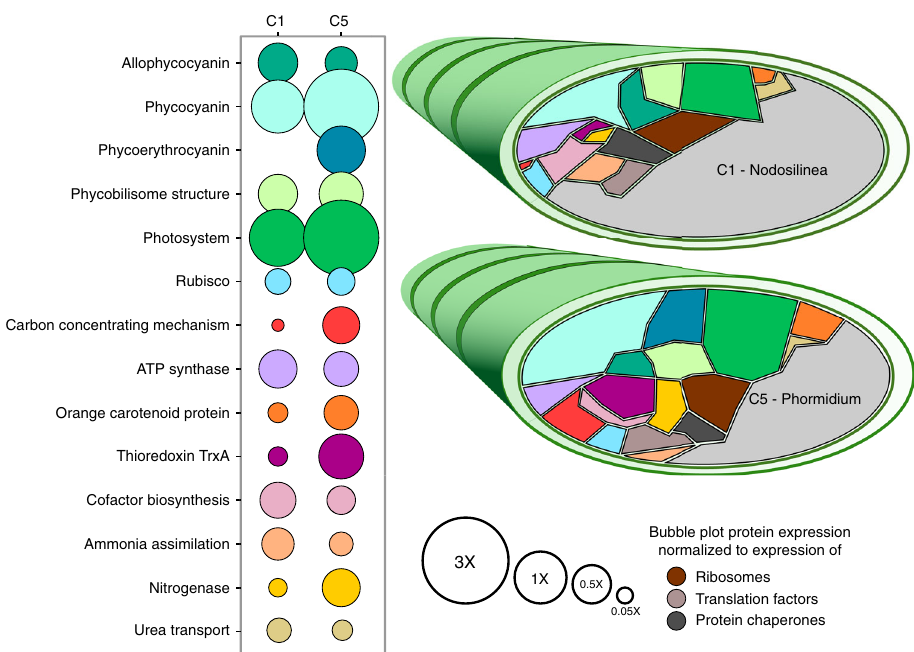
Fig. 4 Protein expression in the most abundant fi lamentous cyanobacteria. Bubble plot and Voronoi diagrams comparing expression levels of functions by MAGs C1 and C5, both associated with fi lamentous cyanobacteria. The area of each shape in the Voronoi diagram is proportional to the percent that protein or subsystem accounts for out of the MAG ’ s expressed proteins. Colour scheme of the Voronoi diagram is the same as the bubble plot. Size of the bubble in the bubble plot is normalized against the relative abundances of ribosomal proteins, translation factors, and protein chaperones in the MAG ’ s proteome. See also Supplementary Data